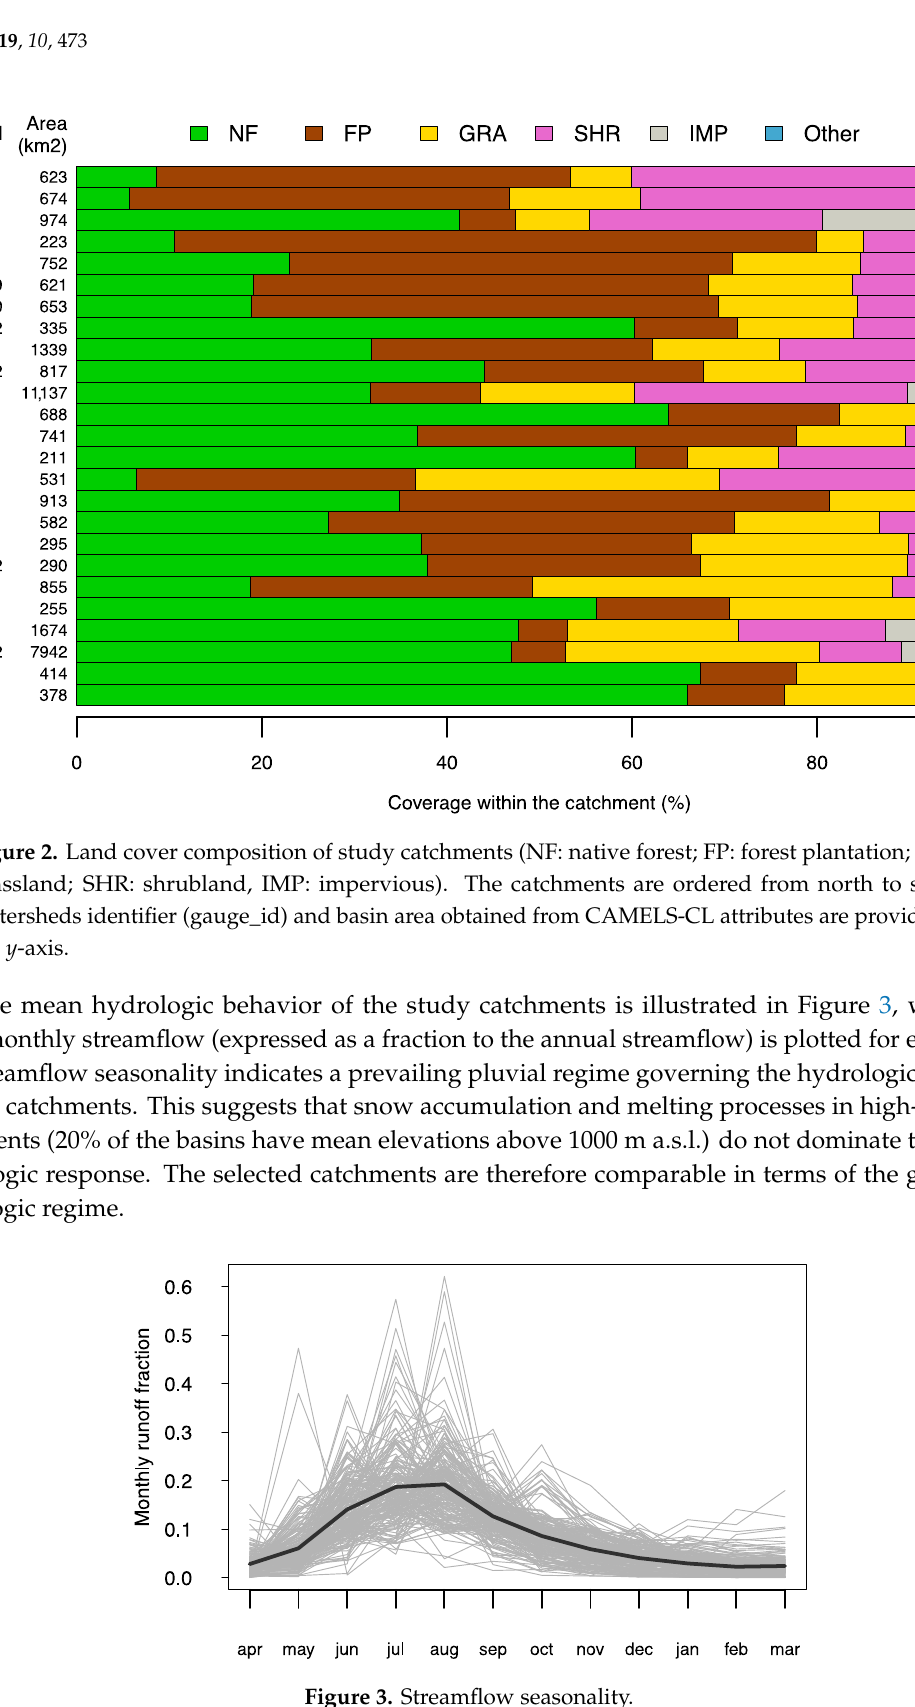
Figure 3. Streamflow seasonality.